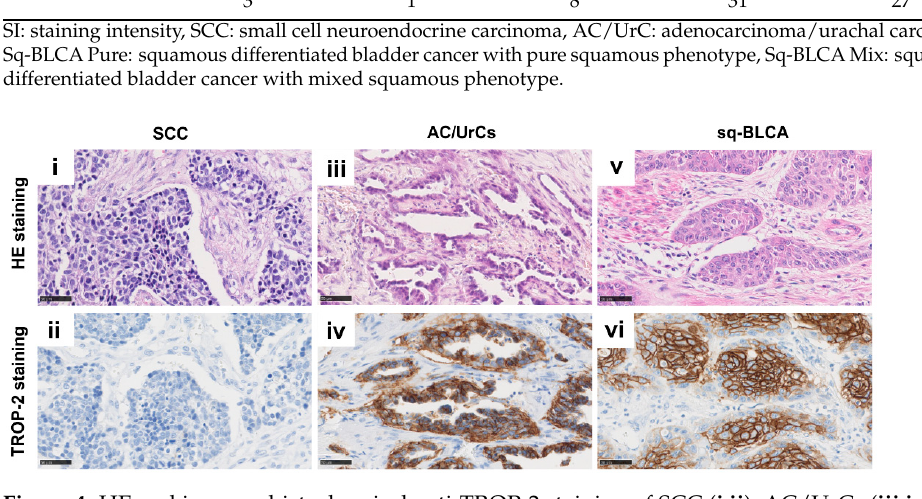
Table 6. Immunohistochemical results of tyrosine kinase receptors in histological subtypes of blad- der cancer.